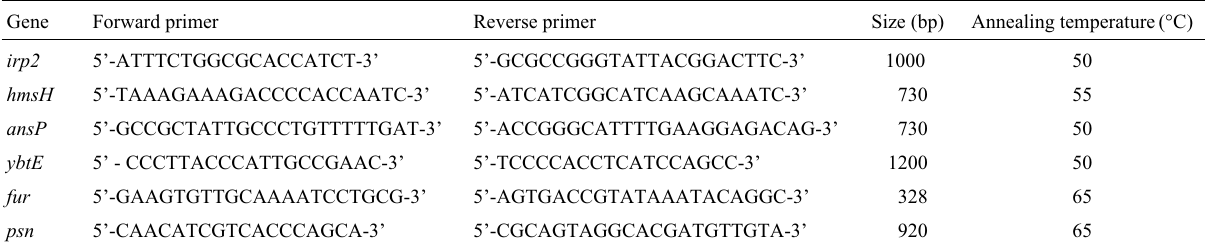
Table 1 - Primers used in the PCR